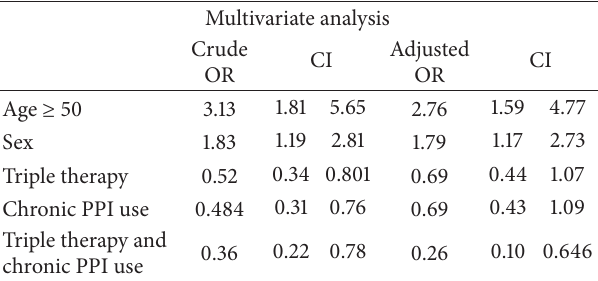
Figure 1: Rates of adenomatous